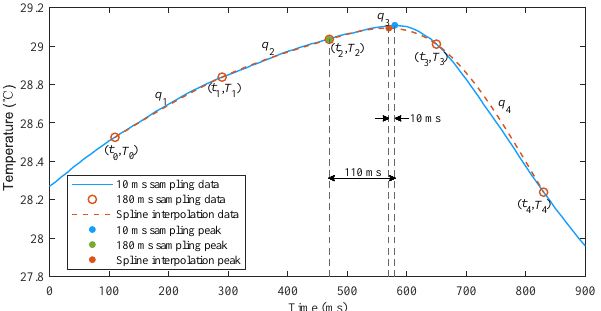
Figure 9. Cubic spline interpolation of temperature